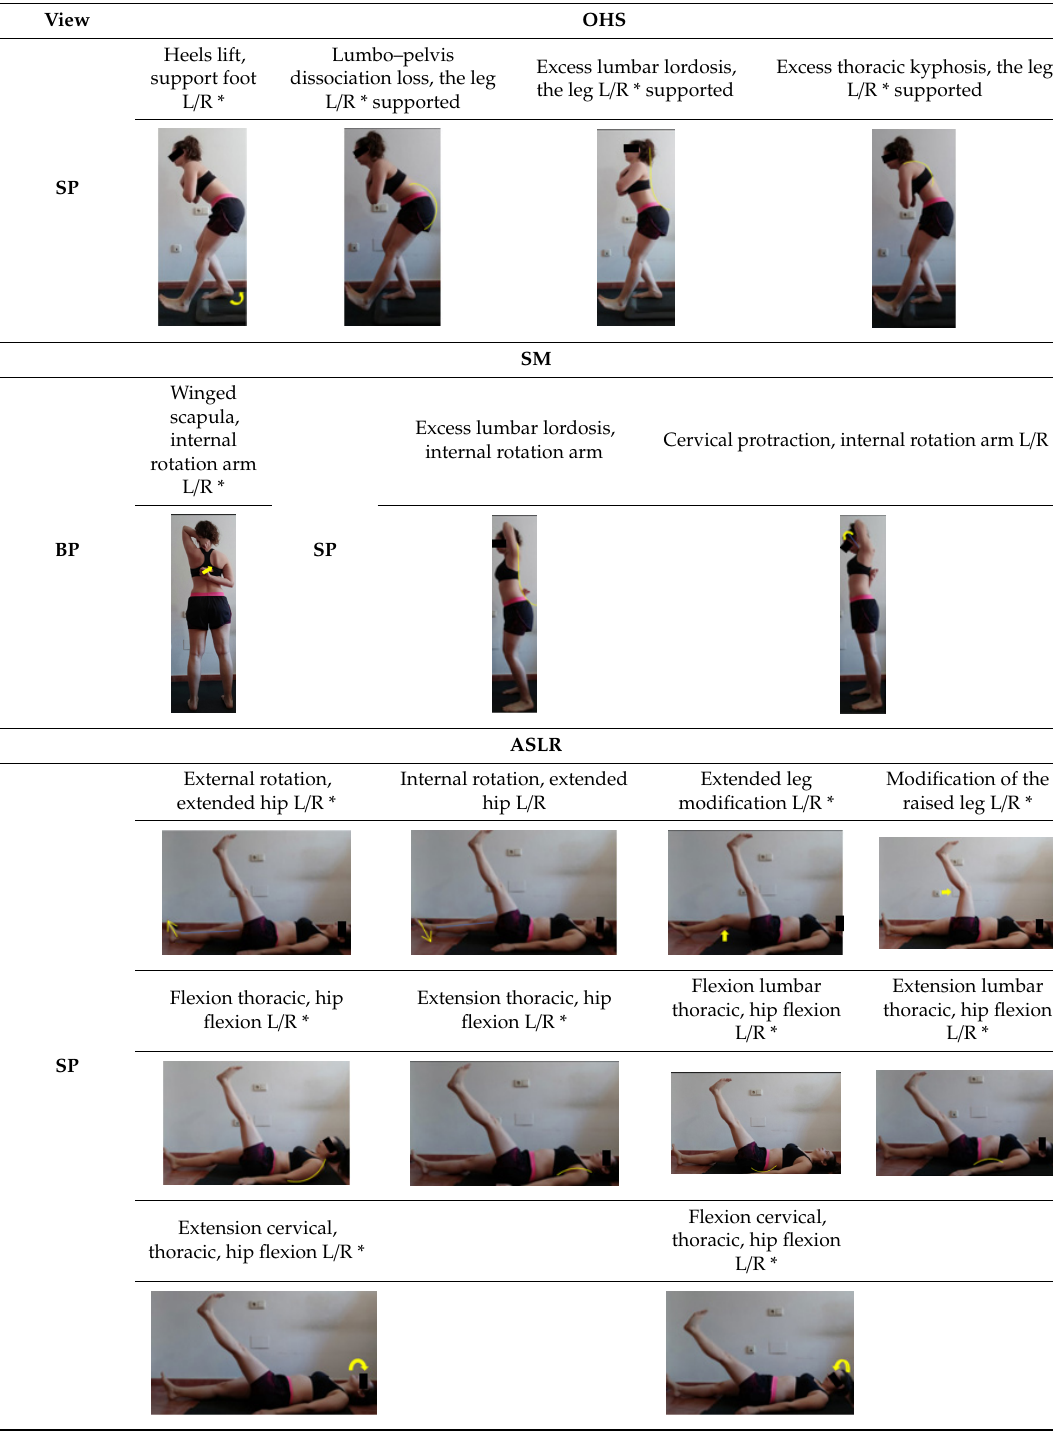
Table 3. Assessment of Aiken V by ten experts of the proposed variables for OHS .